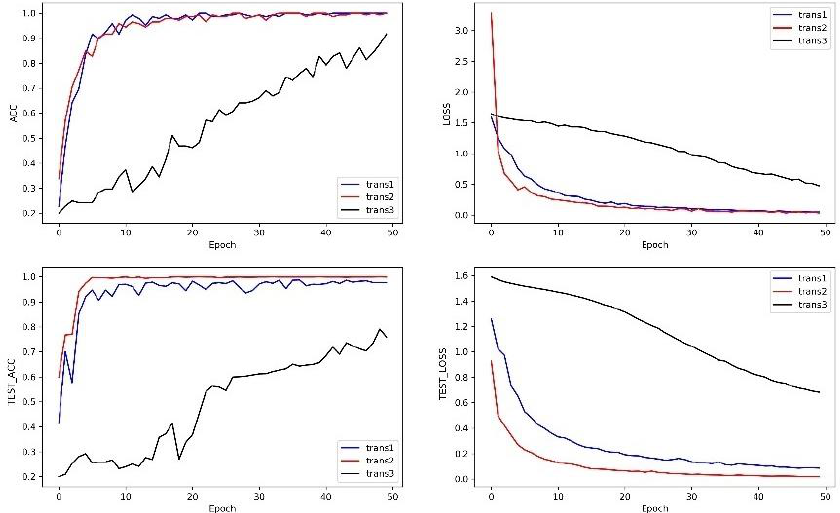
Figure 10. Results of TM3 in different working conditions.